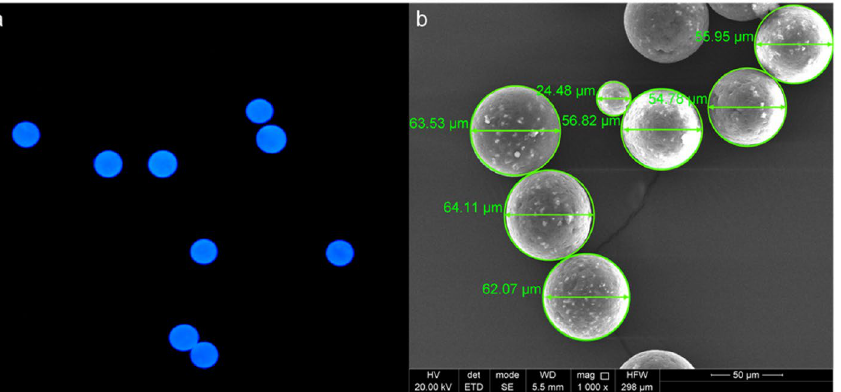
Figure 1. The fluorescent blue-labelled polyethylene microplastics visualised using ( a ) fluorescence microscopy (magnification: 10 x) and ( b ) scanning electron microscopy (magnification: 1000